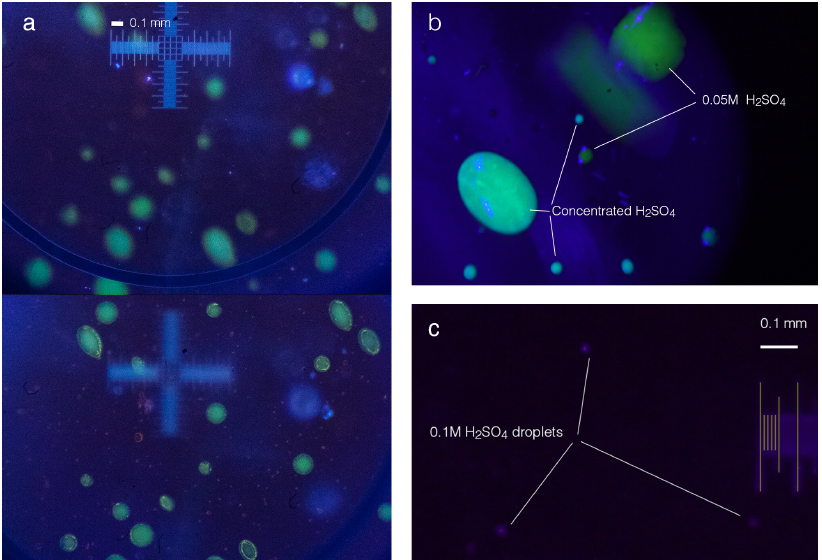
Figure 12. Droplets generated with ultrasonic atomizer under a microscope. ( a ). Concentrated sulfuric acid droplets. ( b ). It is possible to visually distinguish between concentrated (earlier Venusian atmosphere models) and 0.05 M sulfuric acid (roughly corresponding to the neutralized cloud droplet model). ( c ). The smallest droplets generated with an ultrasonic atomizer are around or below 10 µ